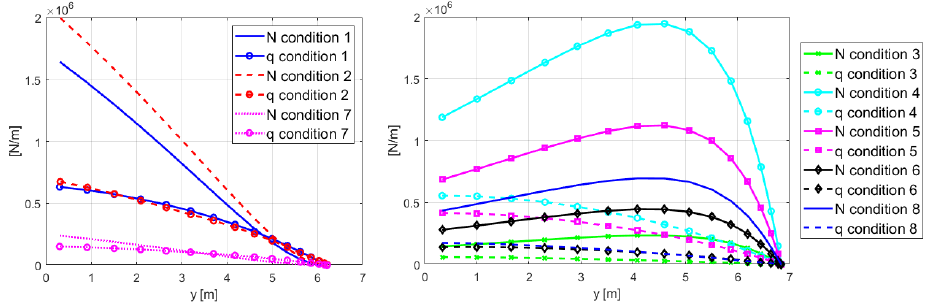
Figure 3. Compression load per unit length and shear flux distributions for symmetric loads in horizontal tail surface ( left ) and for asymmetric loads in vertical tail surface ( right ).